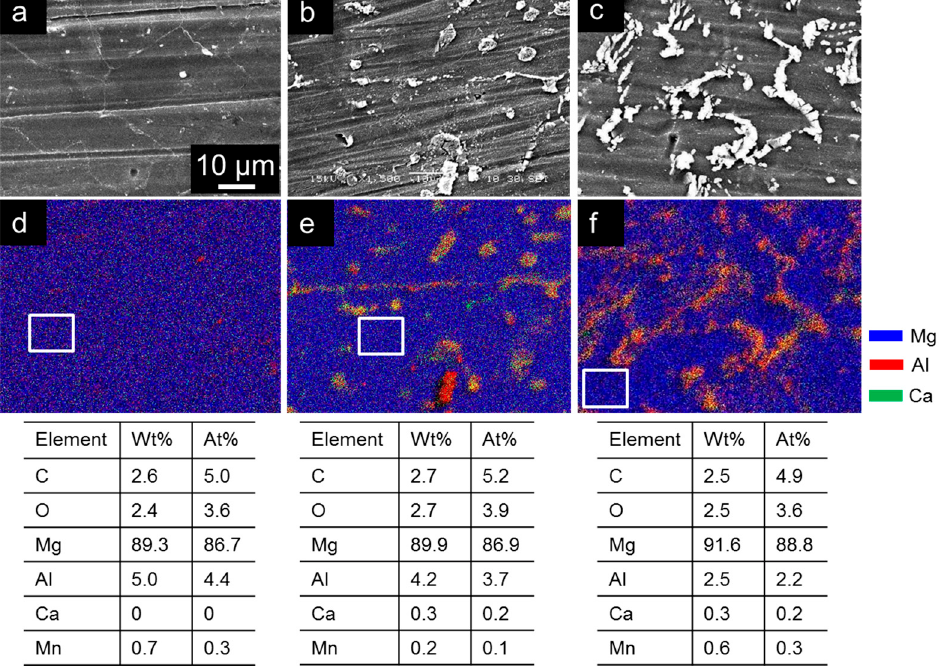
Figure 2. Plane-view scanning electron microscopy (SEM) images of ( a ) AM60; ( b ) AM60-1Ca; and ( c ) AM60-2Ca substrates and the corresponding energy-dispersive X-ray spectroscopy (EDX) maps ( d – f ) showing the distribution of Mg (blue), Al (red), and Ca (green); the tables show the elemental compositional inside the square drawn in each image. The scale bar in image (a) applies to all images.